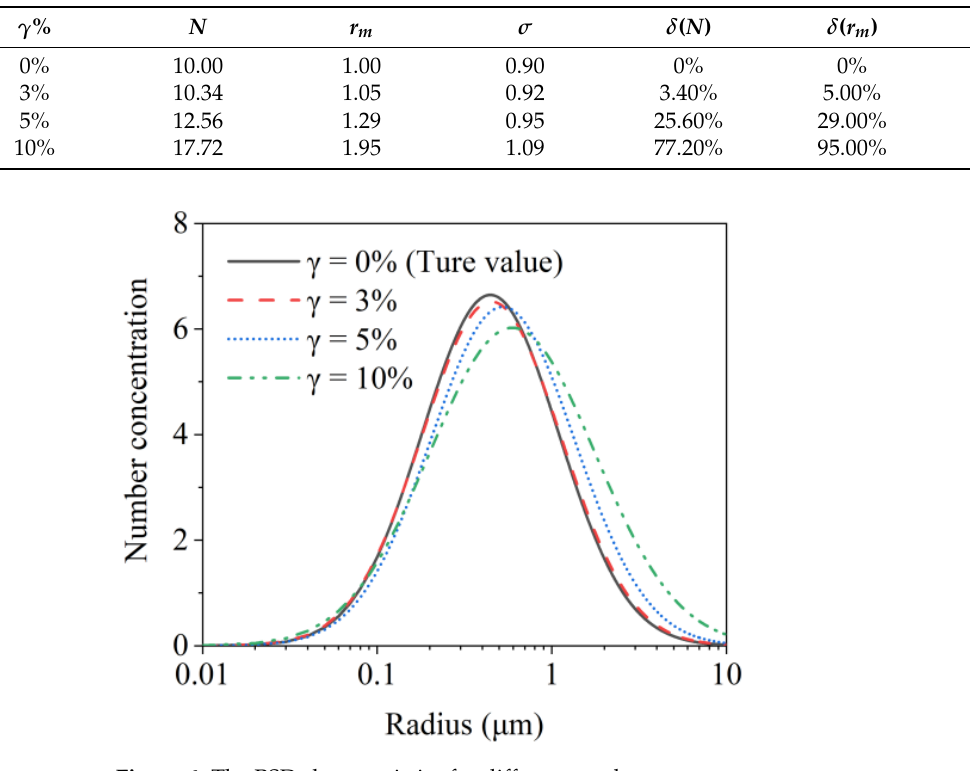
Figure 6. The PSD characteristics for different random errors.